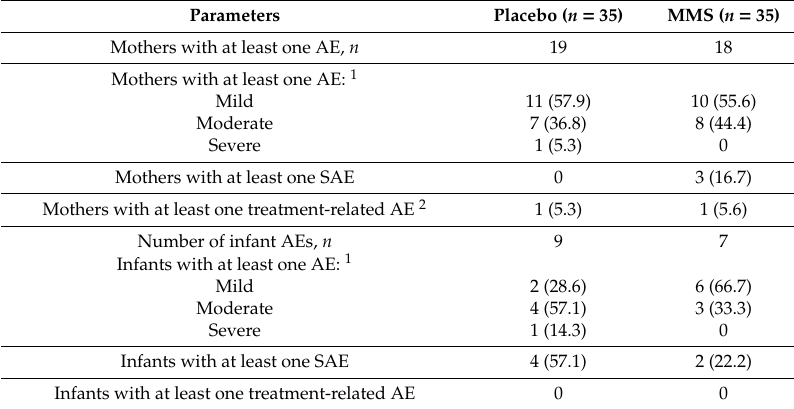
Table 3. Summary of participants who experienced treatment-emergent adverse events (AEs) and suspected treatment-related AEs (safety population; values expressed as n (%)